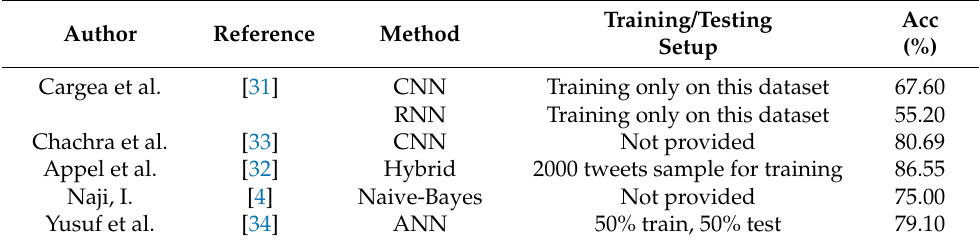
Table 9. Results of other researchers using the same